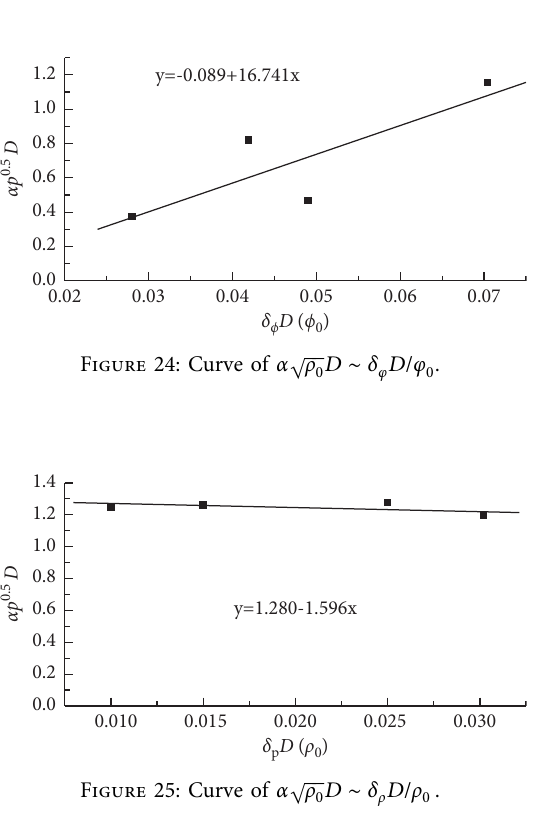
D / c ∼ δ c D / c c 0